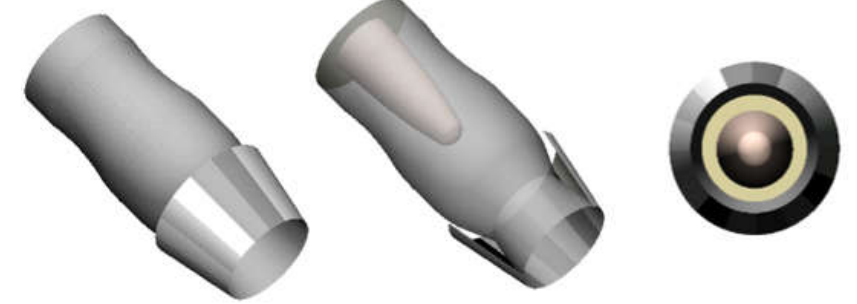
Figure 1. Schematic diagram of nozzle